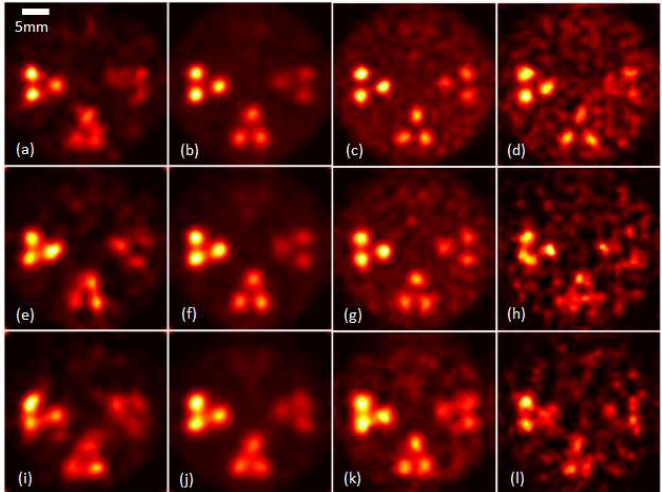
Figure 6. ( a ) FWHM and ( b ) detection limit for PMP and MP geometries for different OPD and PDD values. Results are shown for the nine pinholes. Figure 5. Reconstructed images acquired using ( a ) single pinhole and ( b ) nine pinholes of MP geometry with 5 cm OPD and 5 cm PDD; ( c ) single pinhole and ( d ) nine pinholes of PMP geometry with 5 cm OPD and 5 cm PDD; ( e ) single pinhole and ( f ) nine pinholes of MP geometry with 5 cm OPD and 3.5 cm PDD; ( g ) single pinhole and ( h ) nine pinholes of PMP geometry with 5 cm OPD and 3.5 cm PDD; ( i ) single pinhole and ( j ) nine pinholes of MP geometry with 5 cm OPD and 2.5 cm PDD; ( k ) single pinhole and ( l ) nine pinholes of PMP geometry with 5 cm OPD and 2.5 cm PDD. Results are shown for the third layer of the object. Single pinhole is P22 in Figure 2a.